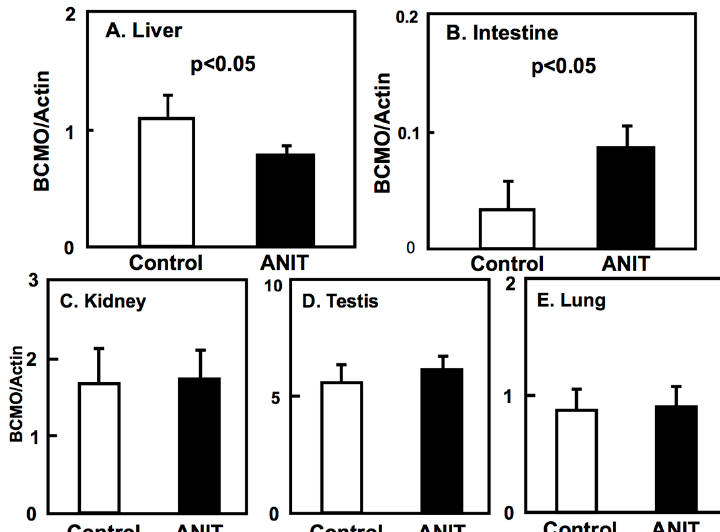
Figure 4. Tissue-specific expression of BCMO in control and ANIT rats. The BCMO mRNA levels of peripheral tissues including liver ( A ), intestine ( B ), kidney ( C ), testis ( D ), and lung ( E ) were examined in treated and controls groups ( n = 5 for each group) by quantitative real-time PCR. Each bar represents the mean value ± SD and significant differences are indicated in the graph.